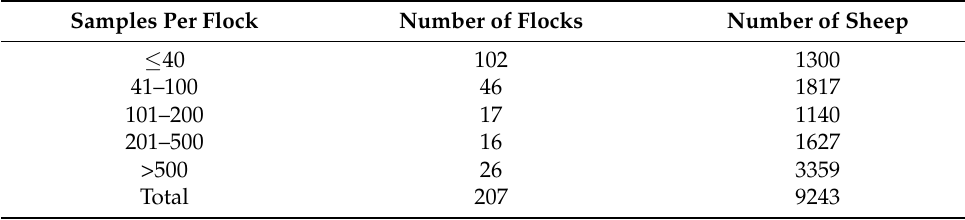
Table 2. Samples per flock, number of farms and number of sheep.